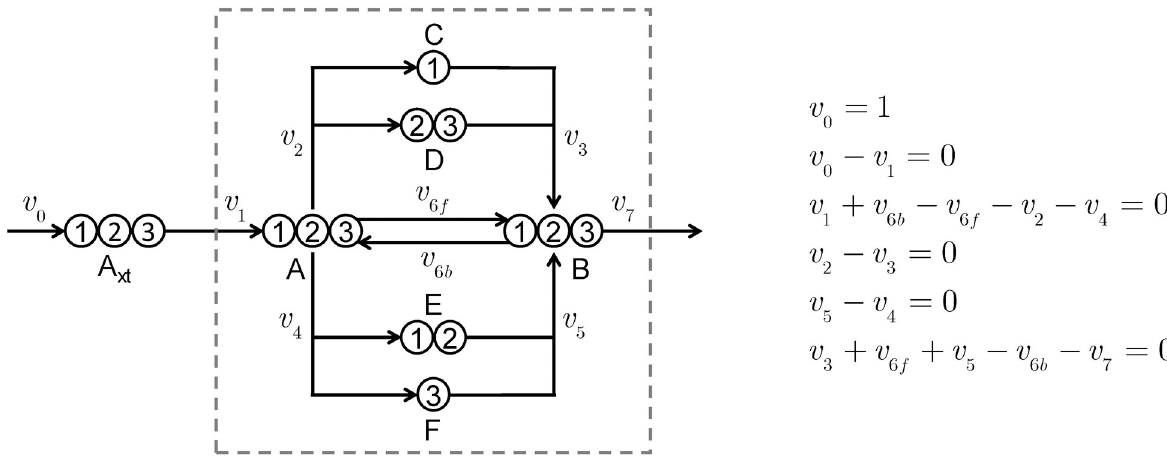
Fig 3. Toy network showing reactions and carbon atom rearrangements with stoichiometric flux constraints. The dashed gray line indicates the cell boundary. Since v 0 is assumed to be known exactly, there are three independent fluxes based on the stoichiometric constraints. There are also six intracellular pool size